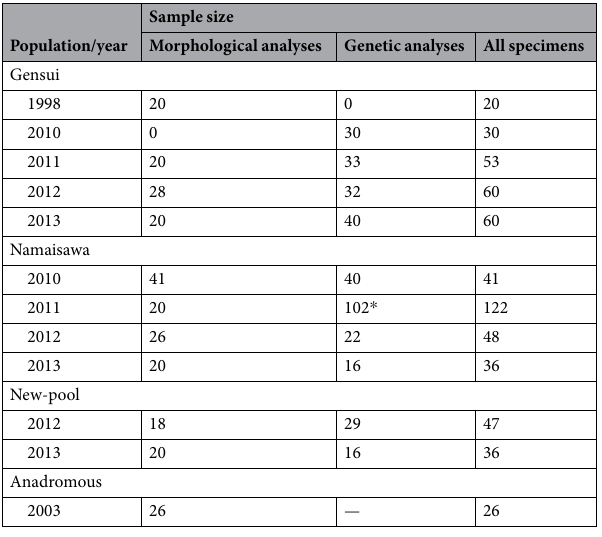
Table 2. Summary of sample sizes. * 55 and 47 fish were adults and juveniles,